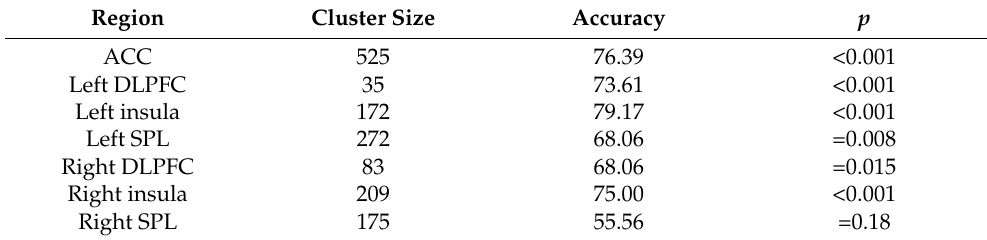
Figure 2. The results of second classifier. ( A ) The whole-brain weighted map. The color bar indicates weight value; ( B ) The top 1% voxel with highest weights (absolute value). Table 1. Decoding accuracies of high and low risk preference participants in top 1% high weighted areas.